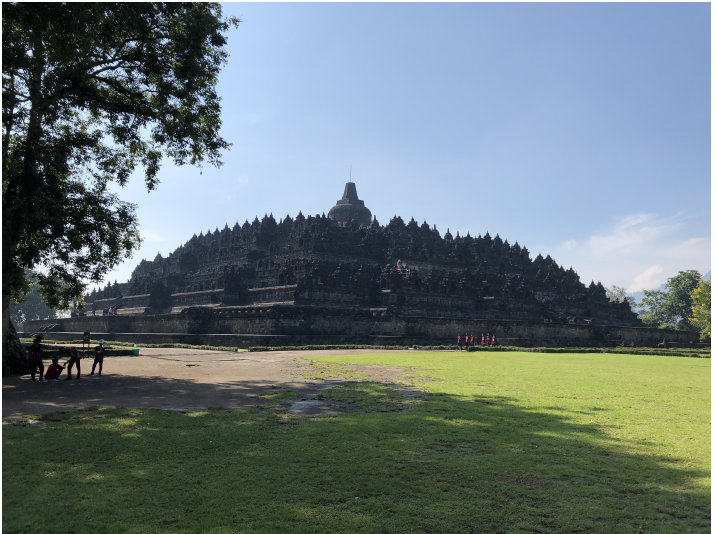
Figure 1. The Borobudur Temple in Indonesia (photograph). The entire temple consists of a series of concentric terraces of decreasing size that rise like steps to a central peak. The first and lowest part is a square base measuring 113 m on each side [20]. The upper platforms have diminishing height and the highest point of the monument is 35 m above ground level.